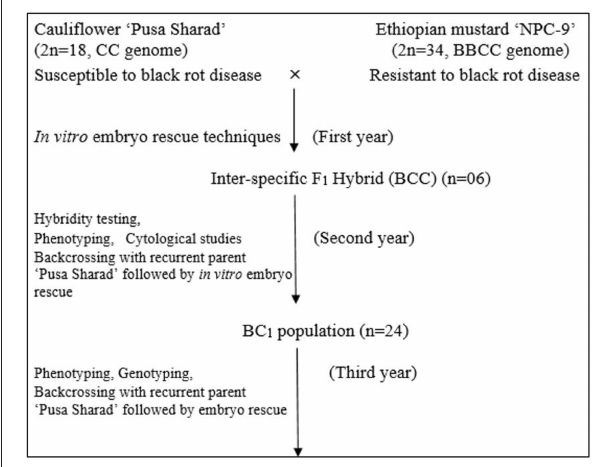
FIGURE 1 | Flow chart of development of plant materials using in vitro embryo rescue